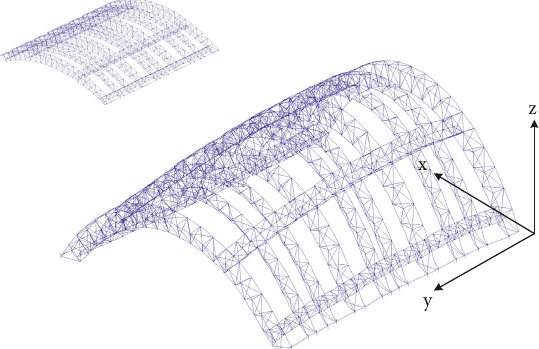
Figure 16: The 4th mode shape (vertical).